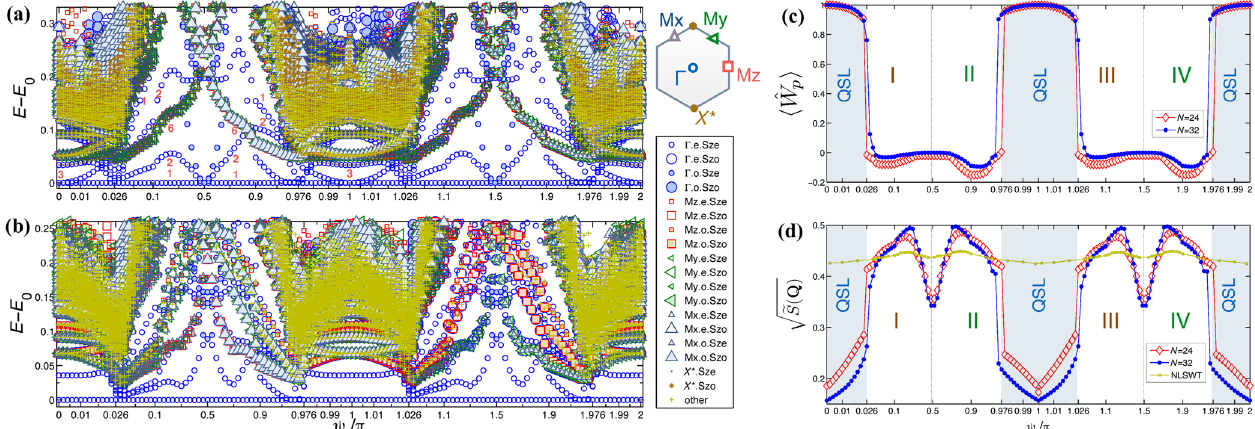
FIG. 3. (a),(b) Exact low-energy spectra (measured from the ground state energy E 0 ) of the 24-site (a) and 32-site (b) clusters, defined, respectively [35], by the spanning vectors ð 2 t 1 − 4 t 2 ; 4 t 1 − 2 t 2 Þ and ð 2 t 1 − 4 t 2 ; 4 t 1 Þ . A nonlinear x axis is used in order to highlight all regions of interest equally. The states are labeled by momenta k in the first BZ, parity ( “ e ” for even, “ o ” for odd) under inversion through hexagon centers, and parity under global spin π rotations around the x axis ( “ Sze ” for even, “ Szo ” for odd). The (red) numbers in (a) denote the multiplicity of the lowest five levels in regions I and II and the ground state degeneracy at ψ ¼ 0 and π . (c) ground state i of Kitaev ’ s flux operators. (d) Square root of the “ symmetrized ” ground state spin structure factor ~ S ð Q Þ (see expectation value h W p text), along with the spin length calculated from a self-consistent nonlinear spin-wave theory